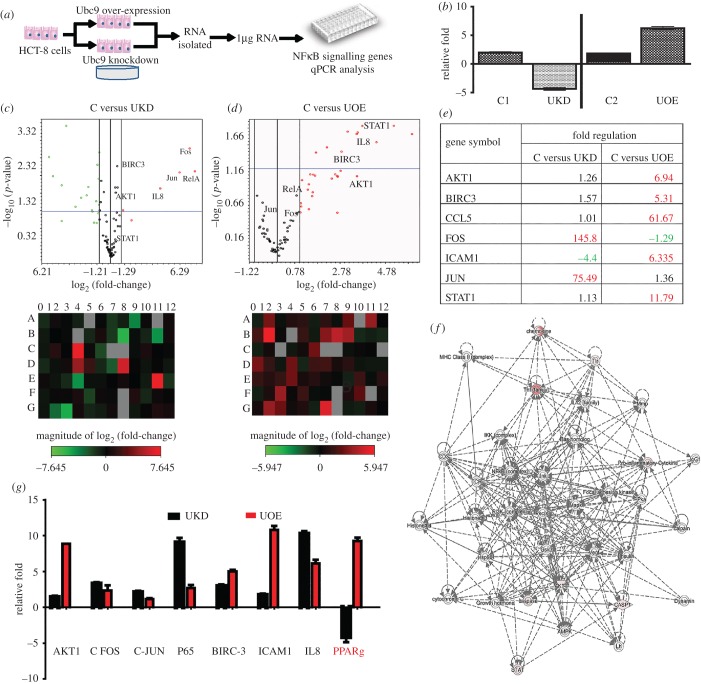
SUMO enzyme Ubc9 controls the expression of inflammatory pathway genes in intestinal epithelial cells. (a) Schematic of steps involved in analysis of gene expression in HCT-8 cells using array-based qPCR. (b) Validation of Ubc9 expression by qPCR in control, Ubc9 knockdown (UKD) using Ubc9-siRNA and Ubc9 overexpression (UOE) samples. The qPCR array experiment was done in triplicate and the data were analysed as volcano plots (c,d)(i) and heat maps (c,d)(ii). The analysis was done as control versus UKD or control versus UOE as represented in (c) and (d), respectively. In volcano pots, horizontal axis shows fold change (log2) and vertical axis represents the statistically significantly dysregulated genes (−log10 scale; p < 0.05, blue line). (e) Table showing the fold change of various significant genes from qPCR array, altered in UKD and UOE samples compared with control. (f) Gene networking by IPA reveals Akt1-dependent IPA functional network in UOE sample. Each line represents a direct interaction/regulation, while dotted line indicates indirect interaction/regulation. (g) Validation of qPCR array data for indicated genes using in-house oligomers.